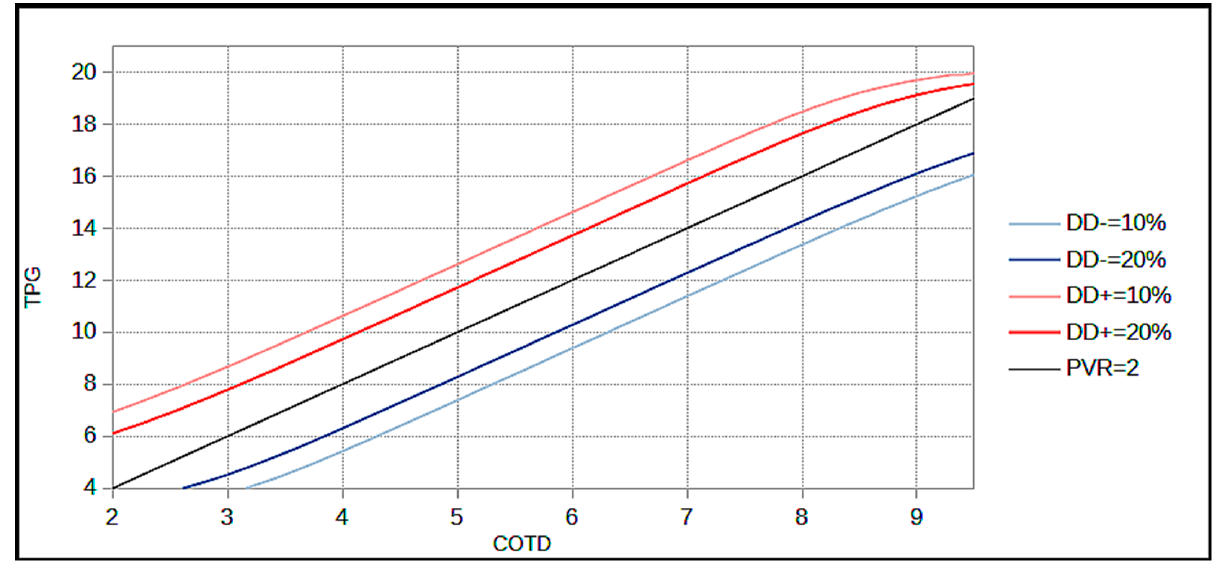
Figure 3. IsoDgDis (diagnosis disagreement) graph: IsoDgDis (DD) lines are represented on the TPG/CO TD graph. The limits of the models are with physiological CO in between 1.3 L/min to 10.2 L/min, 1.96 SD of the bias of 2 L/min and bias of 0 L/min. The isoPVR line of 2 is the diagnosis line (patients above this line are diagnosed with precapillary PH and patients under this line are diagnosed with unclassified PH). COTD: Cardiac Output using Thermodilution; DgDis (DD): diagnosis disagreement (DgDis (DD)+ corresponds to false positive diagnosis using TD; DgDis (DD) − corresponds to false negative diagnosis using TD); PVR: pulmonary vascular resistance; TPG: transpulmonary gradient.